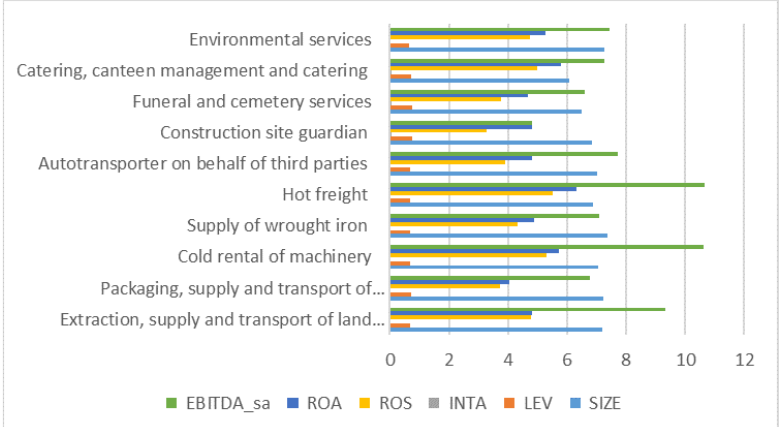
Figure 6. Financial and economic performance indexes of firms (WL). All index are expressed as average during period 2013–2020. Source: Authors processing of AIDA Bureau Van Dijk and Prefectures data